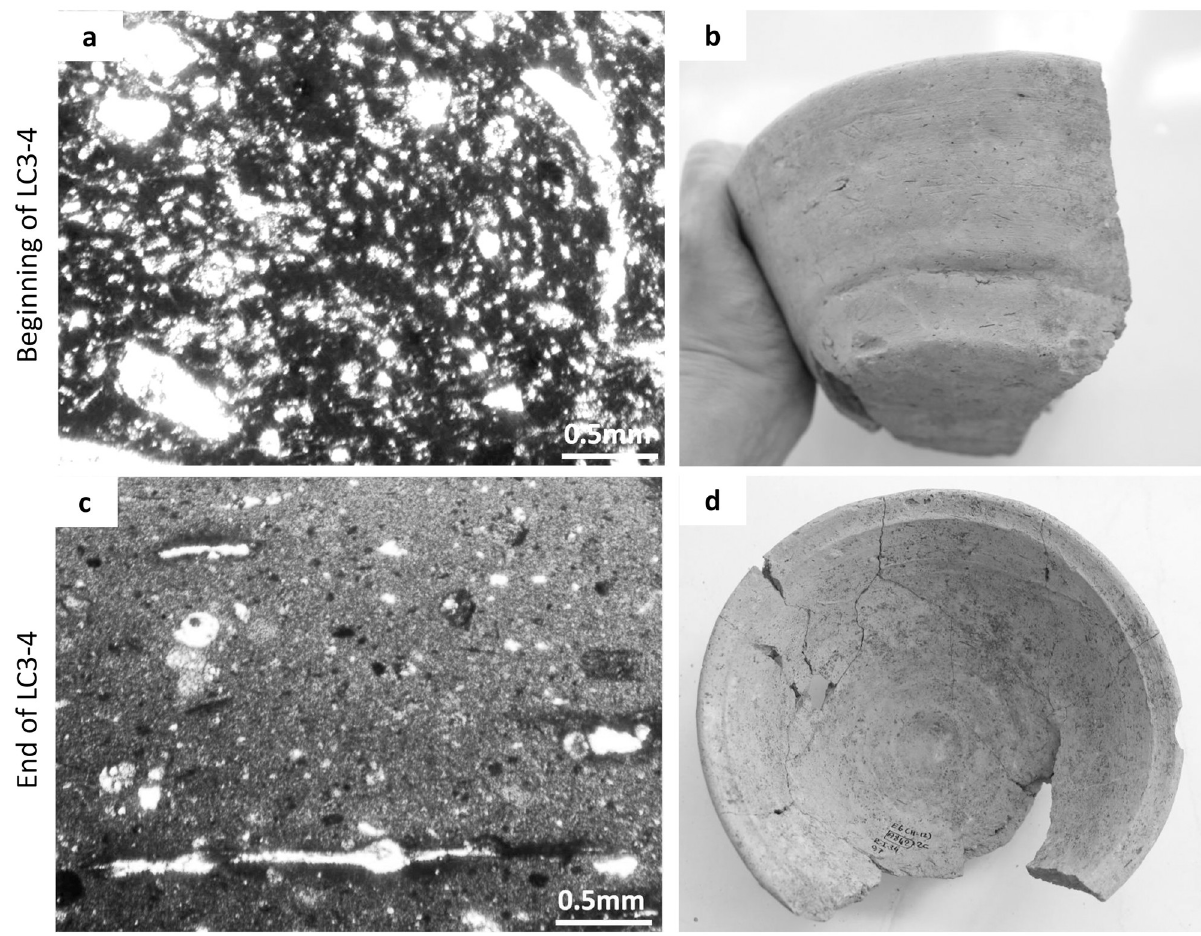
Fig 3. Microscopic and macroscopic features of mass-produced bowls at the beginning and end of the LC3-4 phase, evidencing a diachronic increase in the use of the rotational kinetic energy. Image: O¨AW-O¨AI / P. Fragnoli.